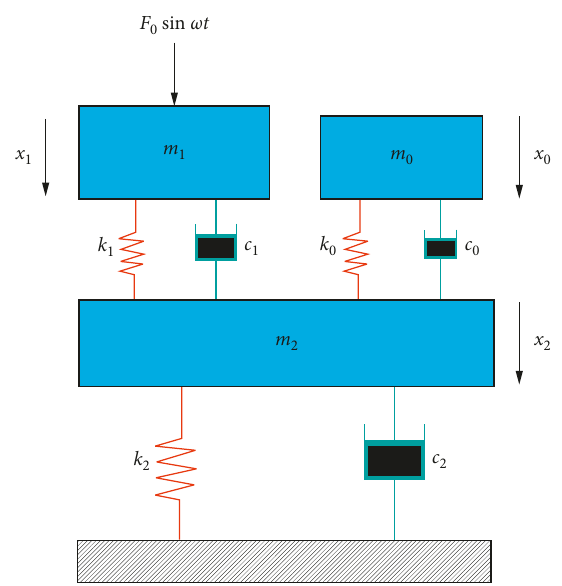
Figure 6: Simplified model of the fastener/tuned slab damper/floating plate